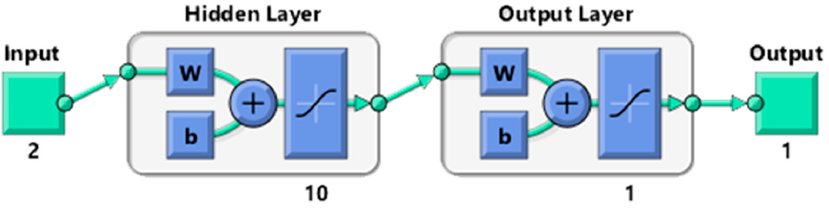
Figure 8. Architecture of artificial neural network used in this study.